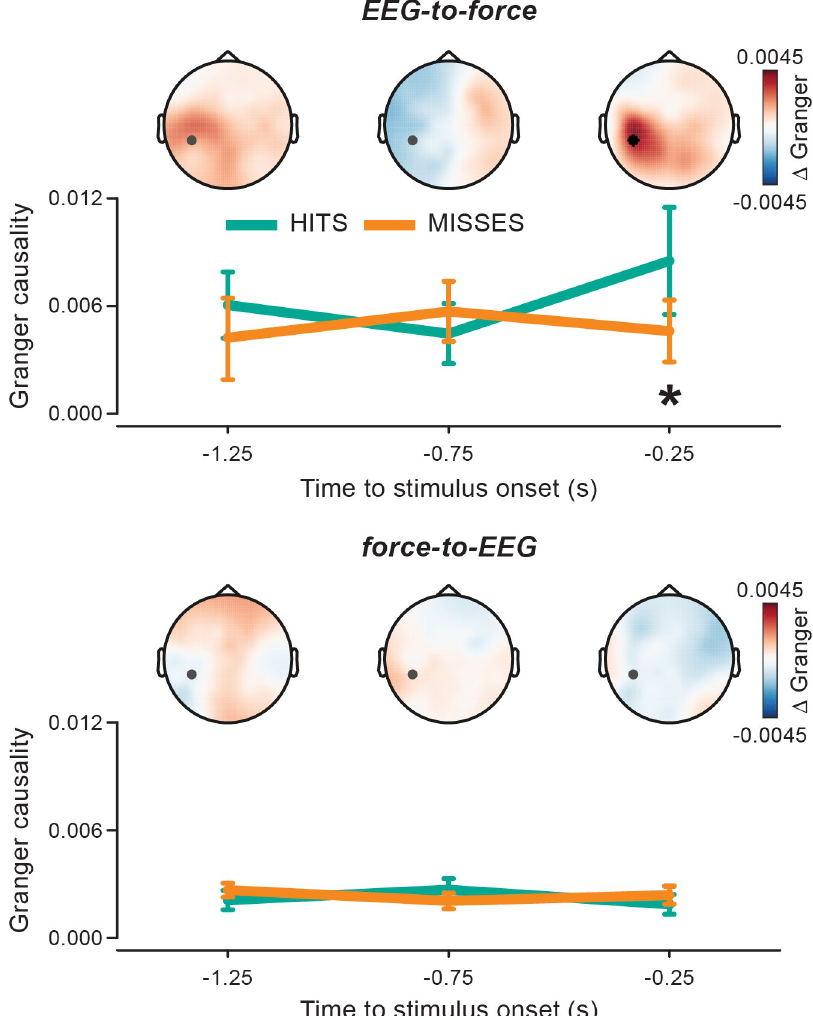
Fig 7. EEG-to-force alpha Granger causality predicts perception just before stimulus onset. Granger causality in the EEG-to-force (top) and force-to-EEG (bottom) directions evaluated at frequency 10.5 Hz and electrode CP5 (marked in gray in the topographic maps) is shown for hits and misses as a function of time before stimulus onset (i.e., for 3 nonoverlapping prestimulus 0.5-second time windows centered at − 1.25, − 0.75, and − 0.25 seconds). Topographies show the hits–misses difference in Granger causality at corresponding times (the black asterisk indicates that electrode CP5 survived permutation statistics for the hits–misses contrast; p = 0.0158). For the underlying data, see https://osf.io/VSZCB/. EEG, electroencephalography.